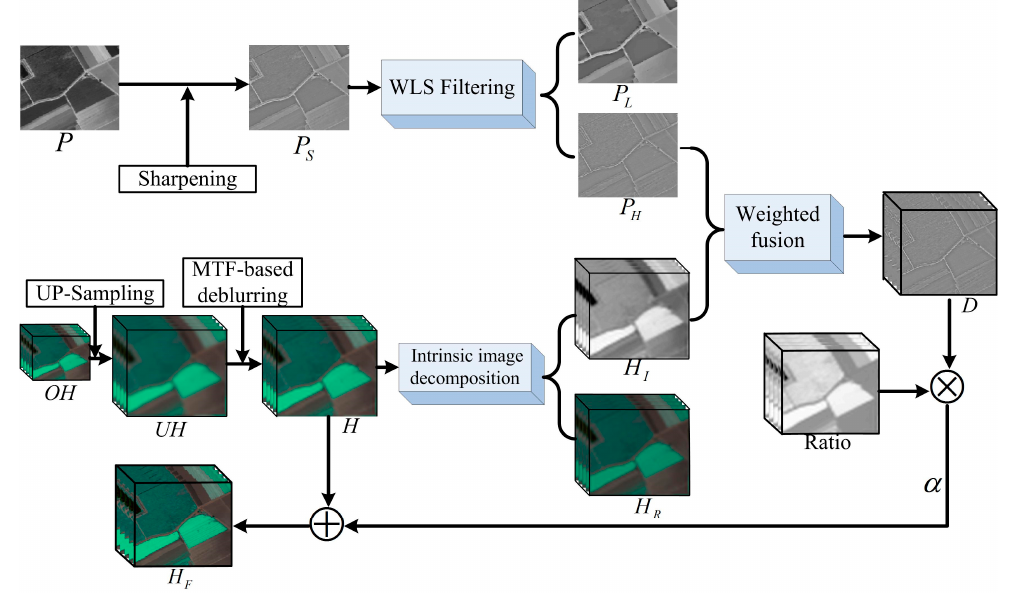
Figure 1. The schematic diagram of the proposed method.